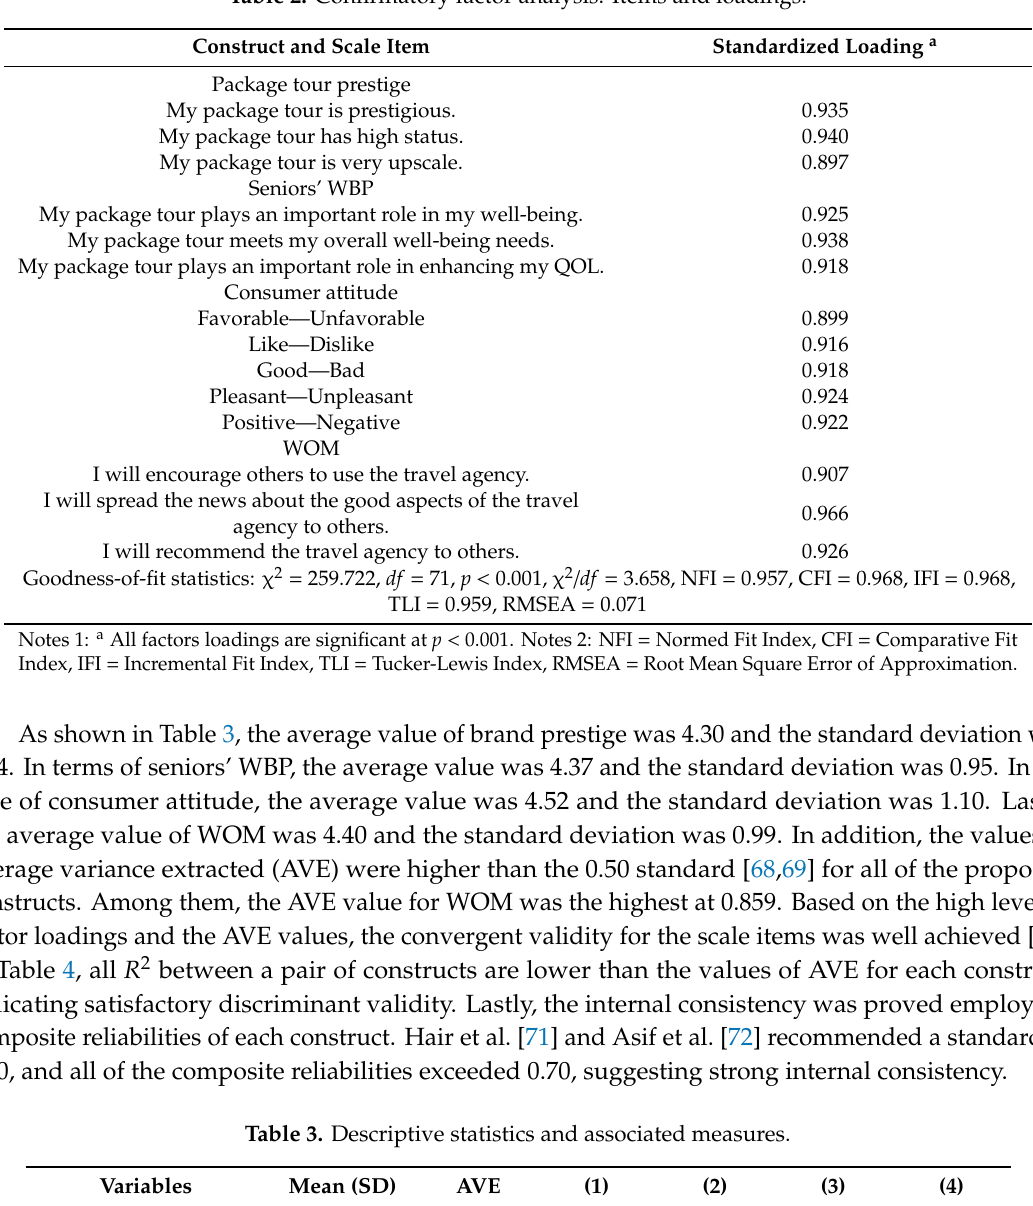
Table 2. Confirmatory factor analysis: Items and loadings.